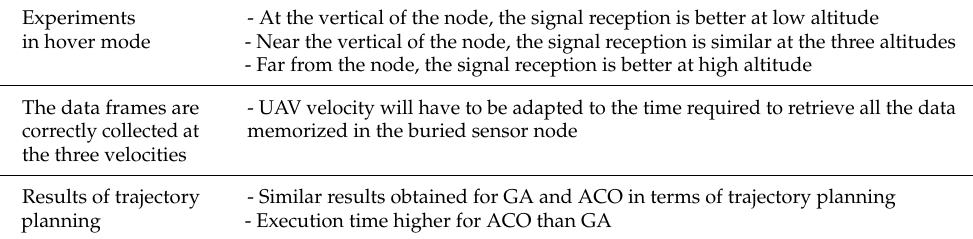
Table 5. Summary of the experimental results.